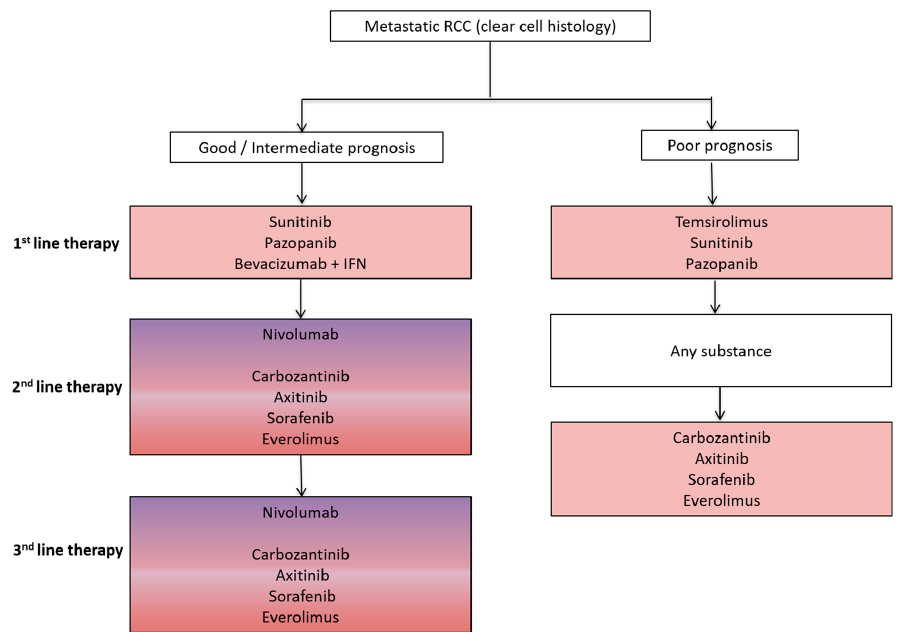
Figure 2. Schematic overview of a standard treatment algorithm in patients with metastatic clear cell renal cell cancer (RCC) according to the 2017 European association of urology (EAU) guidelines including level of evidence and a treatment algorithm based on previous therapies, we refer to the EAU guidelines. Pink: antiangiogenic agent approved as a treatment option; Pink/Purple: both antiangiogenic agent and immunotherapy approved as a treatment option. IFN,